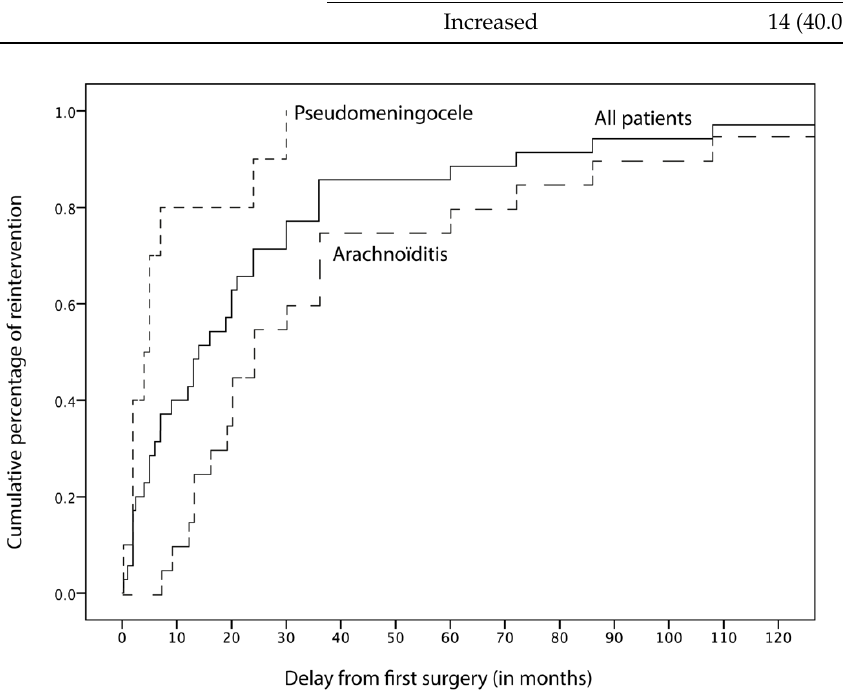
Figure 1. Time to first reintervention following Chiari decompression.